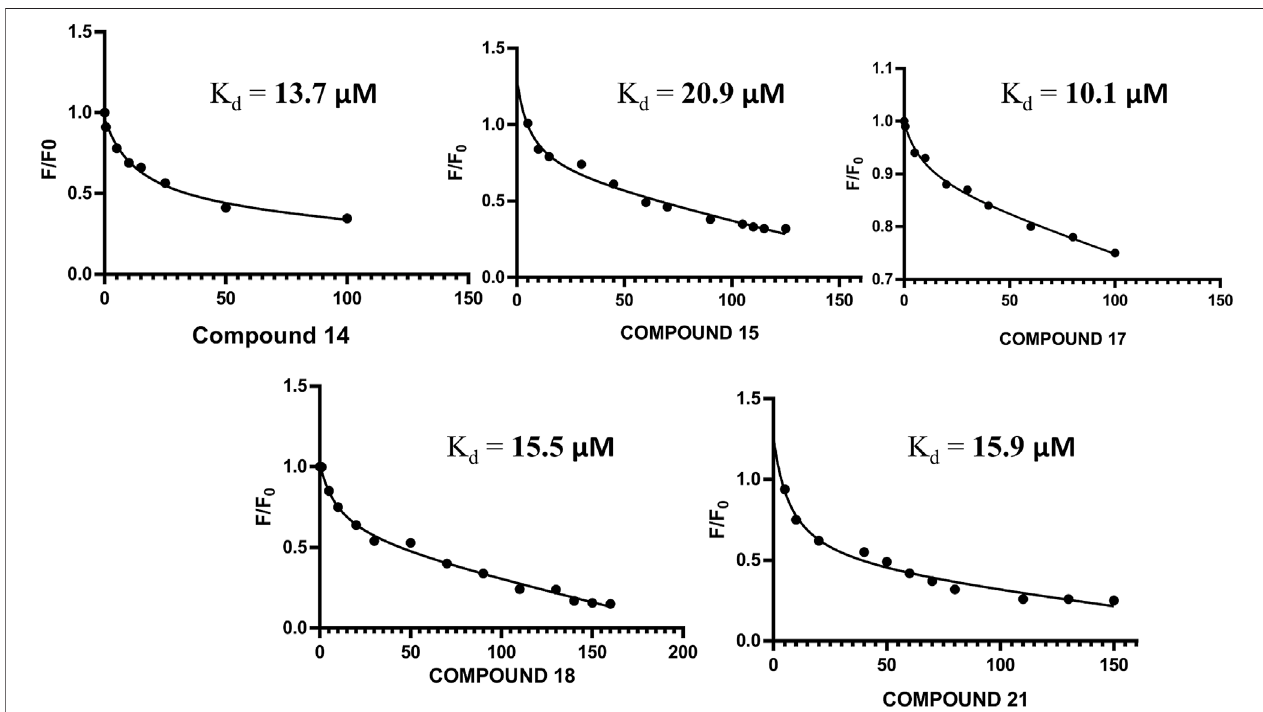
FIGURE 3 | (A) Non-linear regression curve for compound 14 and FGF1 with calculated Kd of 13.70 μ M. (B) Non-linear regression curve for compound 15 and FGF1 with calculated Kd of 20.9 μ M. (C) Non-linear regression curve for compound 17 and FGF1 with calculated Kd of 10.1 μ M. (D) Non-linear regression curve for compound 18 and FGF1 with calculated Kd of 15.50 μ M. (E) Non-linear regression curve for compound 21 and FGF1 with calculated Kd of 15.9 μ M.